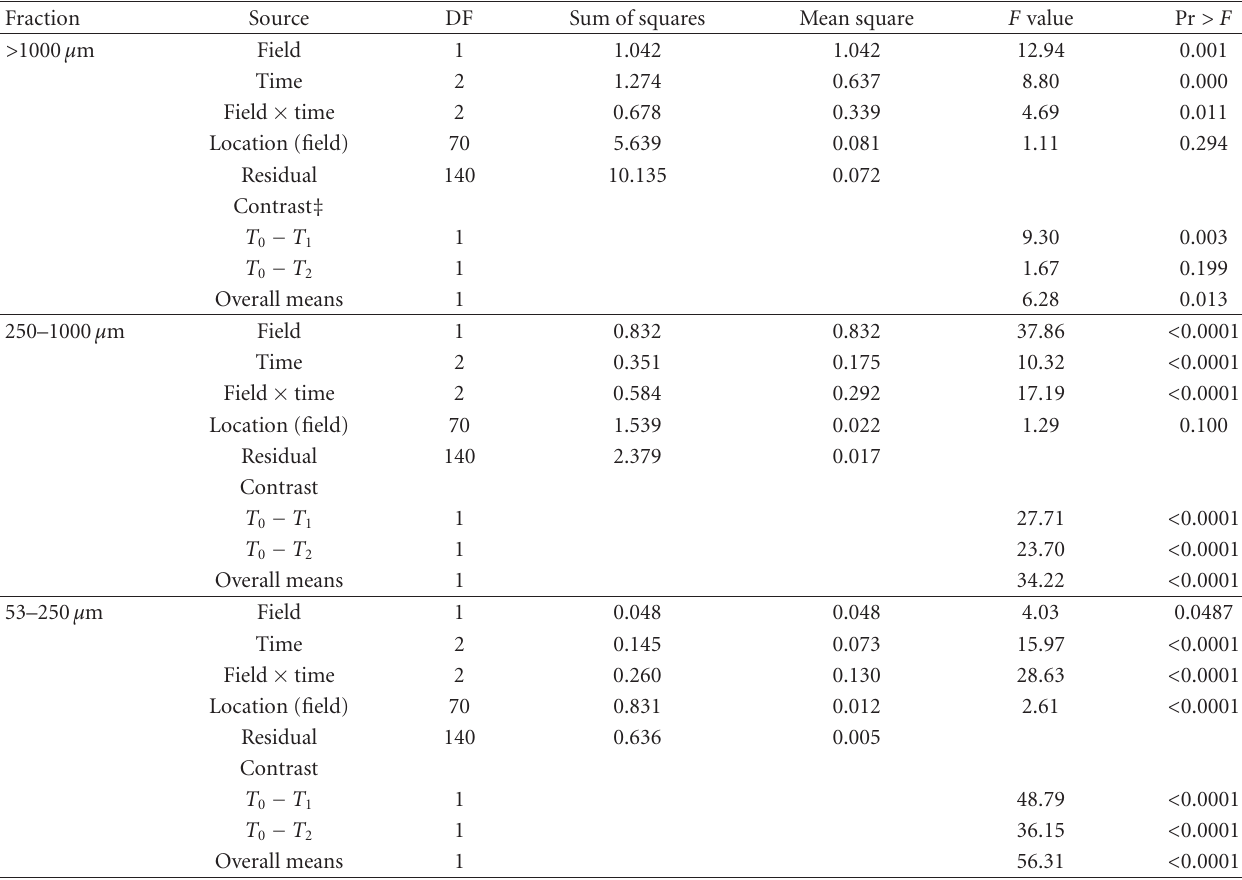
Table 3: E ff ect of standard tillage and no-till on particulate organic matter (POM)-C (BACI † analysis). All the POM-C fractions were log